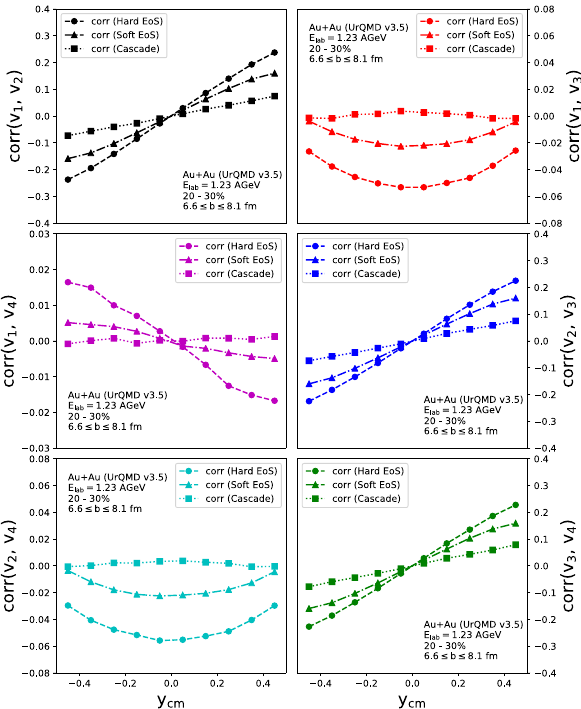
Fig. 8 The Pearson correlation function corr (v n ,v m ) (full symbols) between the first four flow harmonics of nucleons as a function of rapid- ity for a hard EoS (circles), a soft EoS (triangles) and in cascade mode (squares)from20–30%peripheralAu+Aucollisionsat1.23AGeVfrom